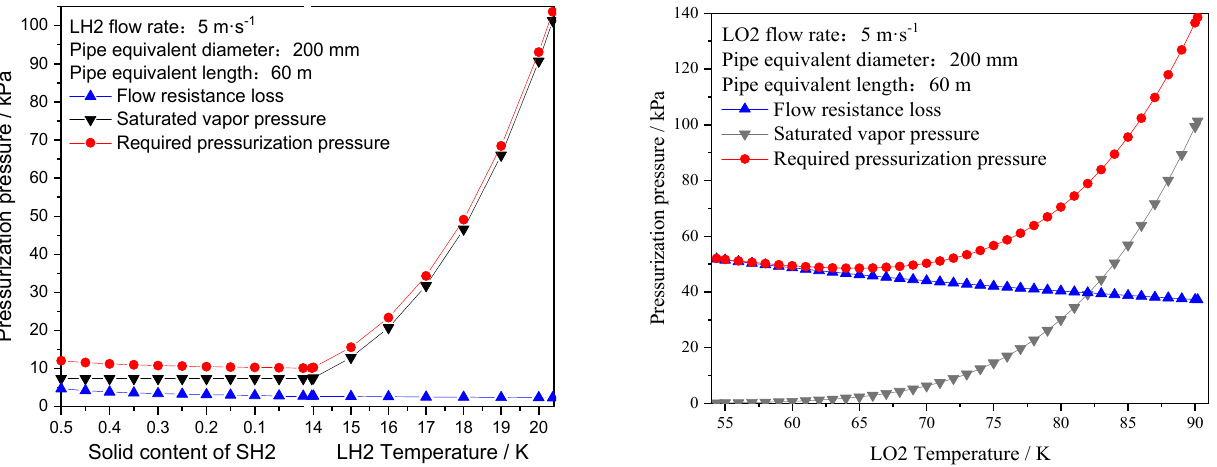
Figure 7. Relationship between LH2/LO2 densification degree and required pressurization pressure of the tank.